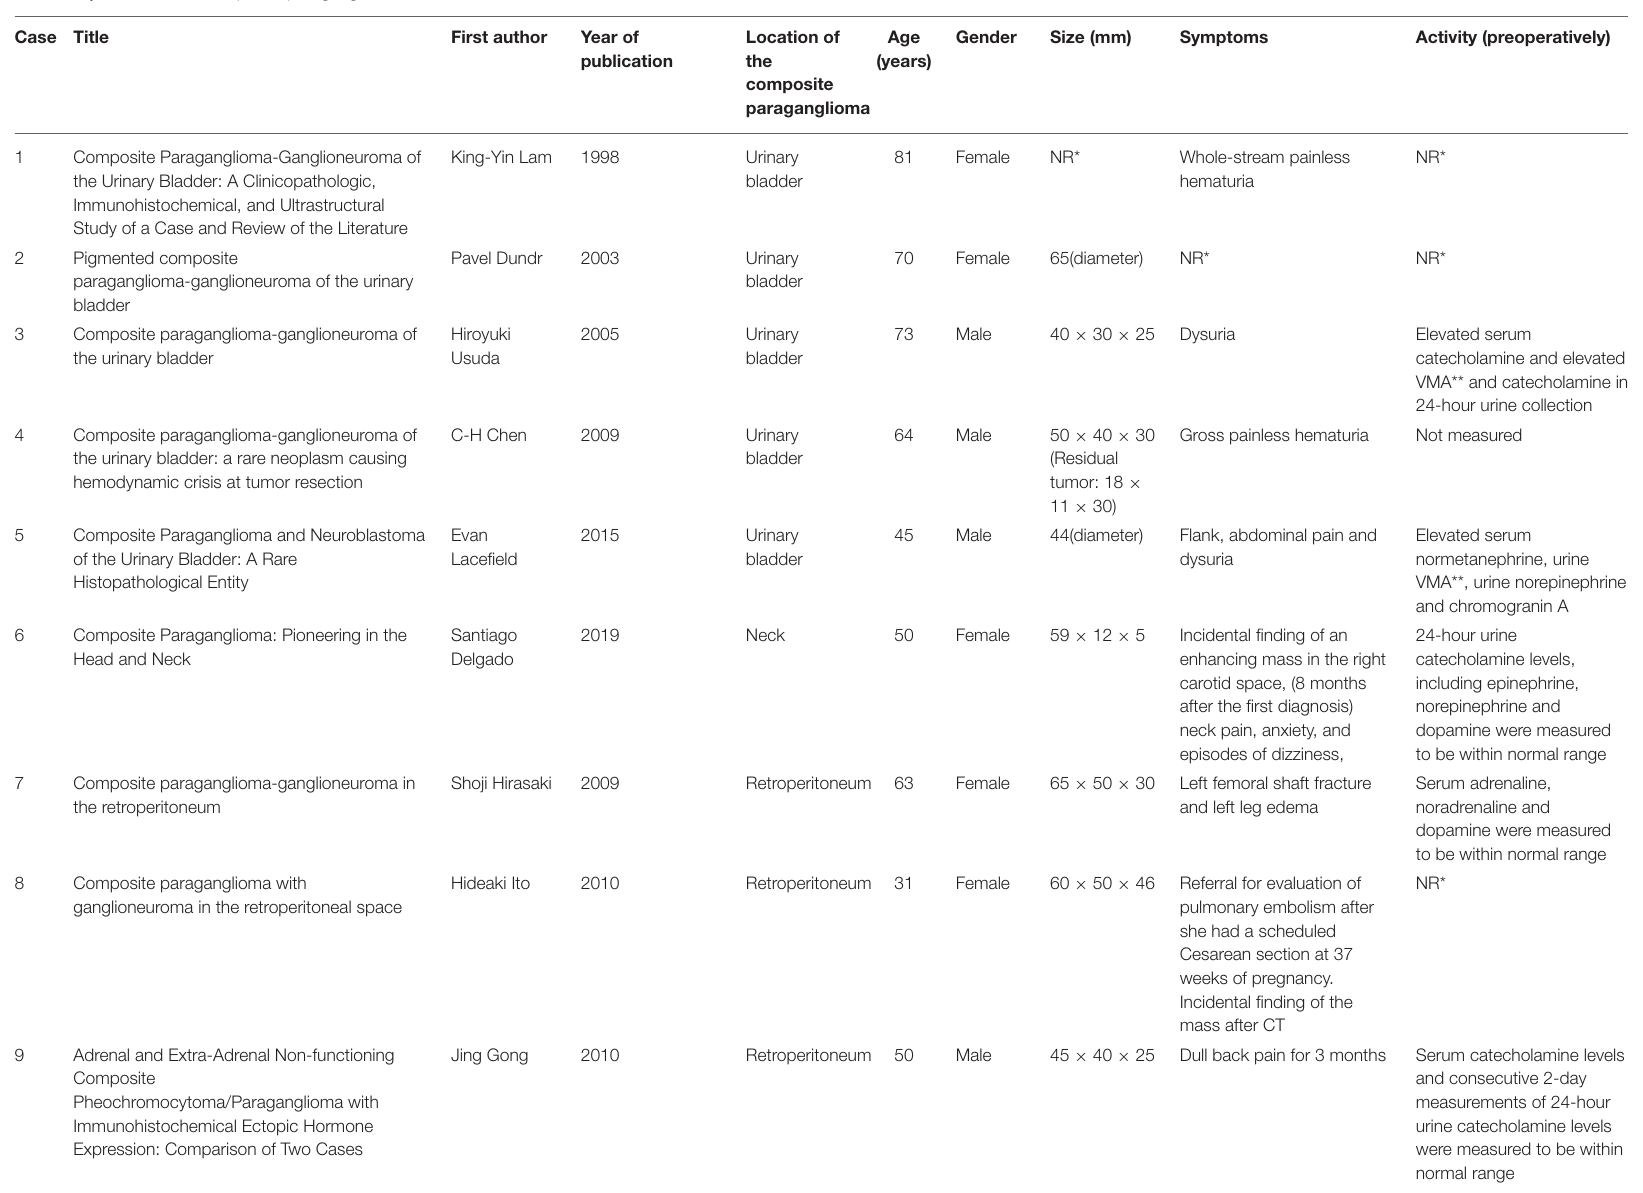
TABLE 2 | Extra-adrenal composite paragangliomas referred in the